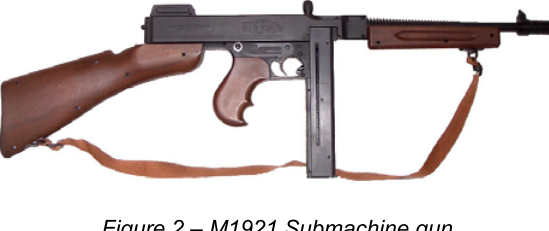
Figure 2 – M1921 Submachine gun Рис . 2 – Автомат М 1921 Слика 2 – Аутомат